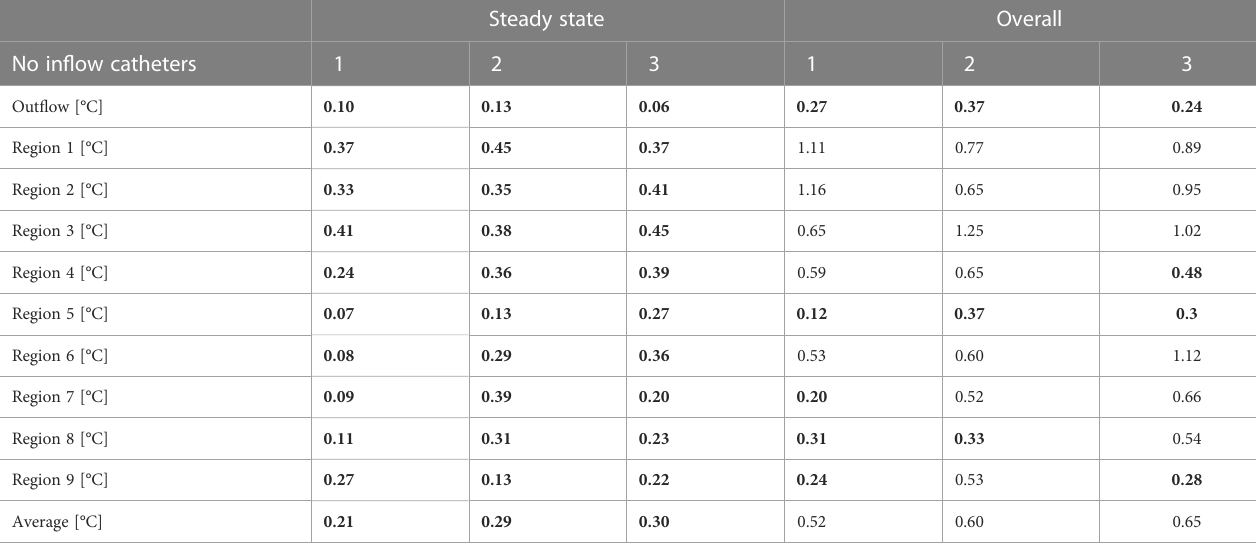
TABLE 6 Absolute errors between predicted an measured values for catheter variations (cases #1, #6 and #7). Steady